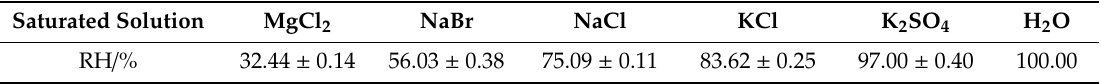
Table 3. Relative humidity of saturated solution at 30 ◦ C